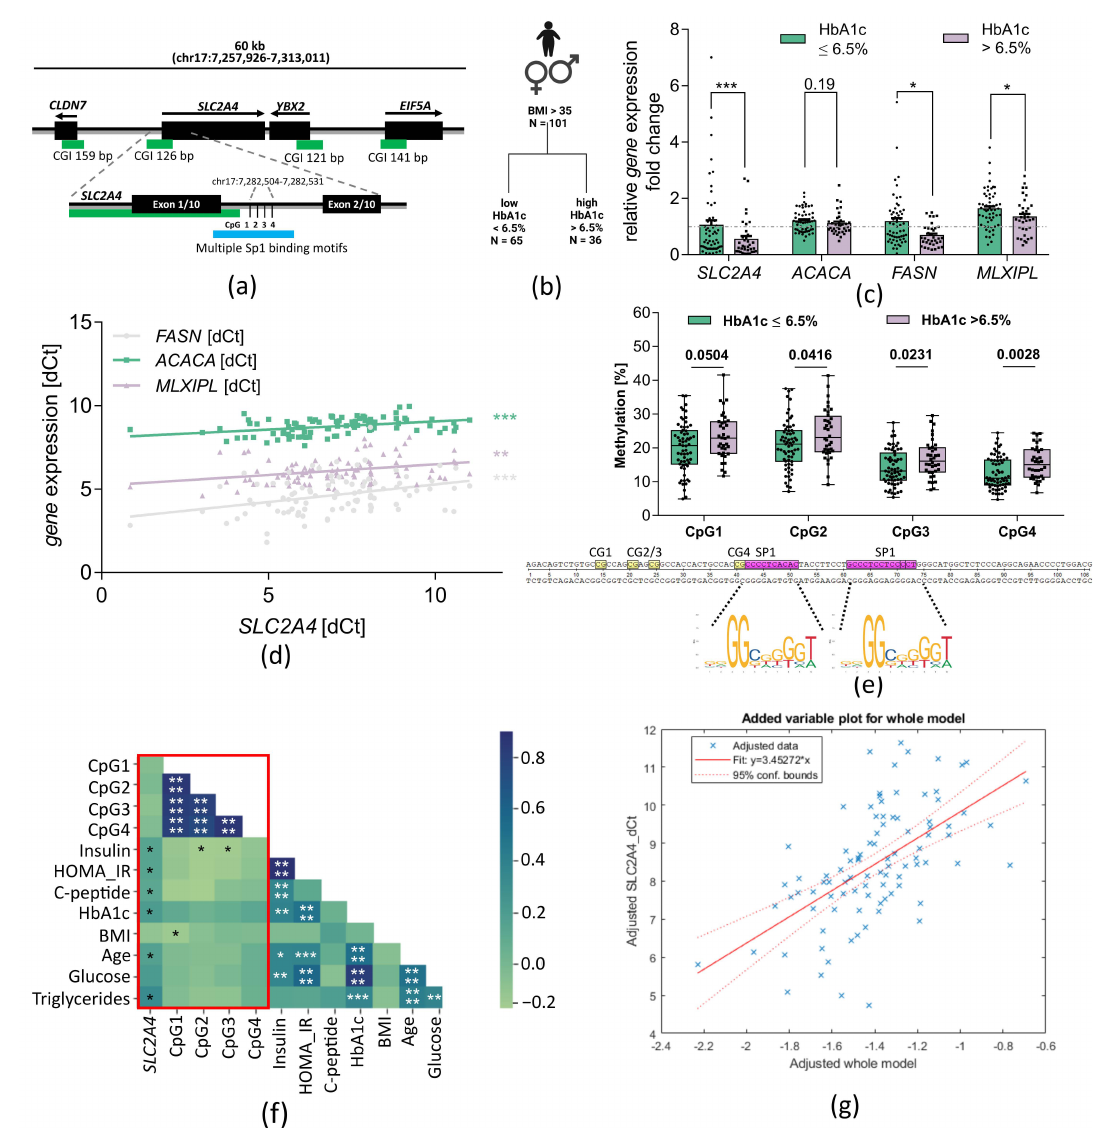
Figure 2. SLC2A4 gene expression and DNA methylation in humans. ( a ) Overview of the SLC2A4 gene and the CpG sites that were analyzed for DNA methylation. The ROI is downstream of the first exon and includes four CpG sites in the proximity of multiple Sp1 binding motifs. Green bars indicate CpG islands, black bars indicate genes or exons; ( b ) Overview of the human cohort used for analysis of DNA methylation and gene expression in VAT; ( c ) Relative gene expression of SLC2A4 (l-HbA1c = 58; h-HbA1c = 35), ACACA (l-HbA1c = 57; h-HbA1c = 35), FASN (l-HbA1c = 58; h-HbA1c = 35), and MLXIPL (l-HbA1c = 56; h-HbA1c = 35) in VAT of morbidly obese individuals. Gene expression was measured with RT-qPCR. Fold change to obese individuals with low HbA1c is shown as mean ± SEM. Mann-Whitney test was performed after testing for normal distribution using the D’Agistino&Pearson normality tests. ( d ) Pearson correlation of SLC2A4 , ACACA , FASN, and